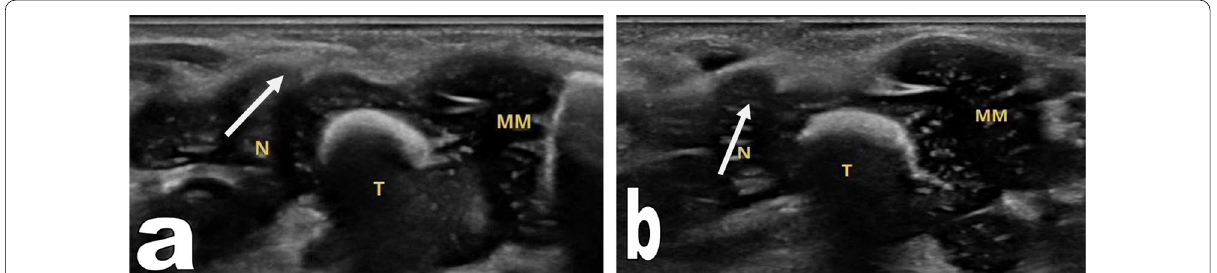
Fig. 11 Bilateral vertical talus in a 23-day-old boy. Dorsal sagittal view a in neutral position, a dorsal dislocation of the navicular on the head of the talus. b Irreducibility of the dorsal displacement of the navicular in maximal plantar flexion. (N malleolus of